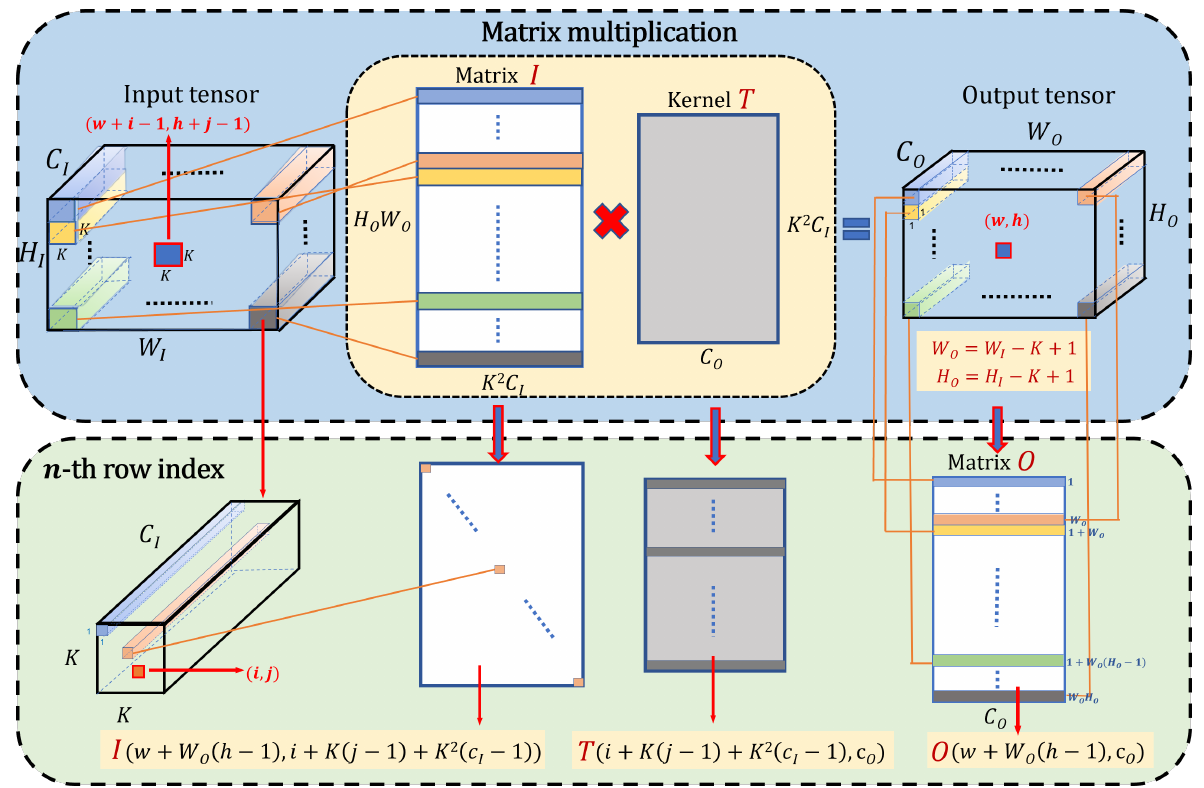
Figure 1. Tensor Train convolutional process: The top shows a convolutional layer can be reformulate to a matrix-by-matrix multiplication O = I × T , the bottom introduces how to calculate the n -th row of the matrices that correspond to the K × K × C I patch of the input tensor as Equation (2)